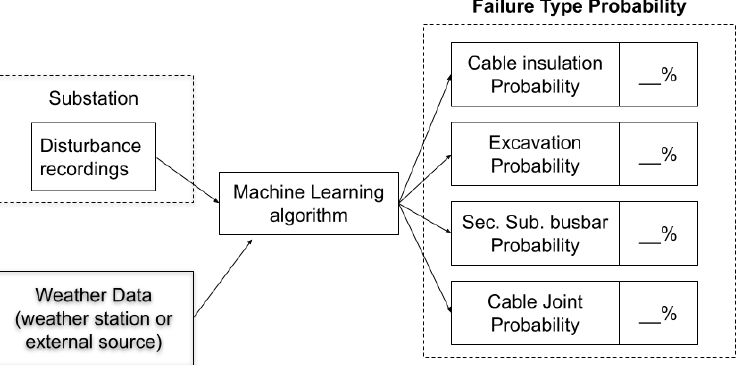
Figure 1. Depiction of the intended goal of the authors work by providing the best possible failure type estimate with data available in almost real time.